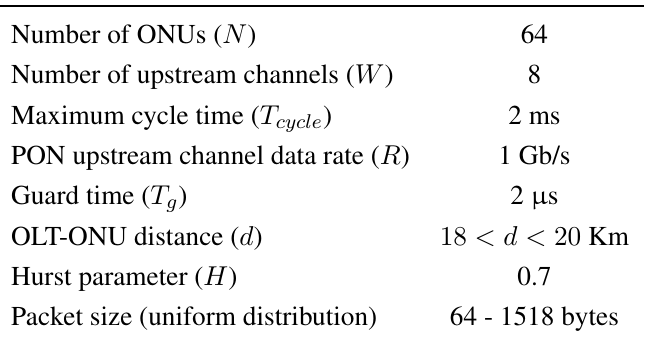
Table 2. Simulations